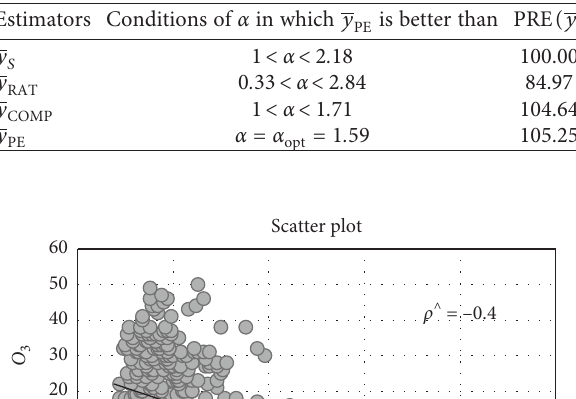
Table 1: PRE (·) of each estimator with respect to y of α in which y is better than others. PE Estimators Conditions of α in which y y S